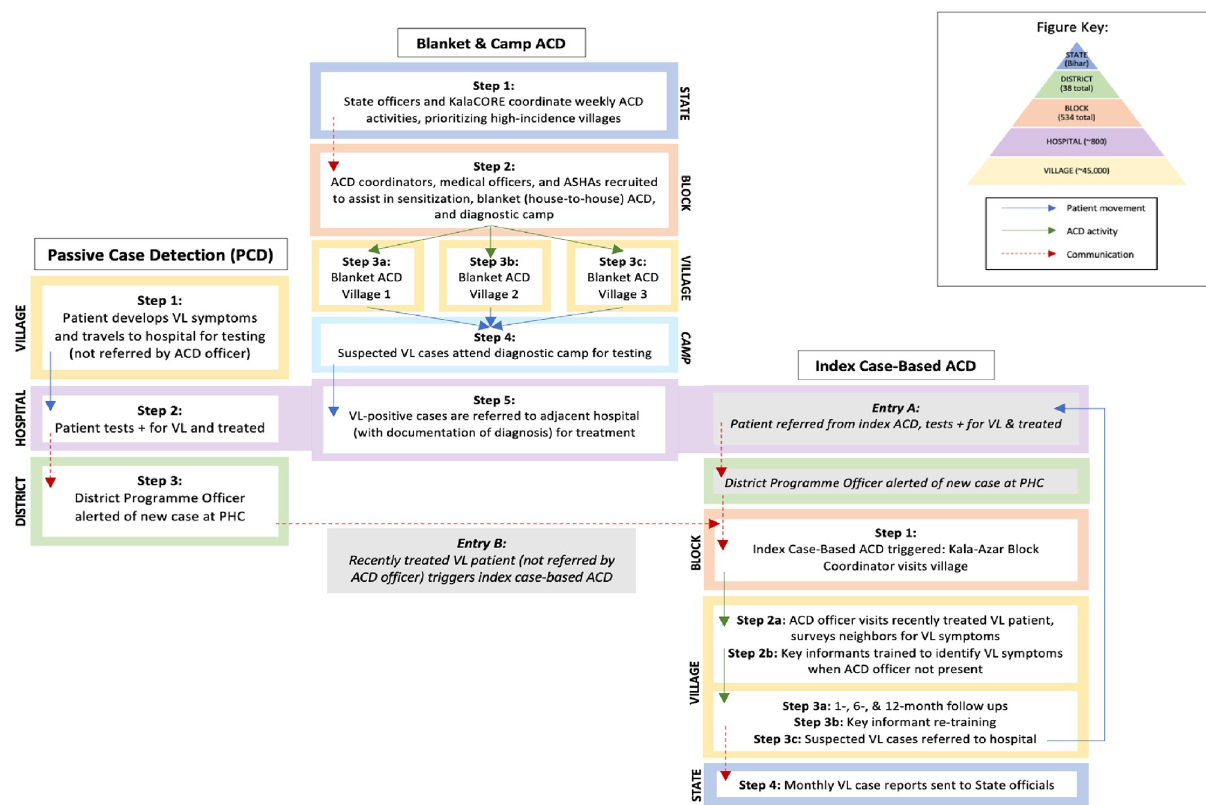
Fig 1. Diagram of VL active and passive case detection in Bihar. Activities, communication, and patient flow involved in PCD, blanket and camp ACD, and index case-based ACD for visceral leishmaniasis in Bihar, India during 2018.